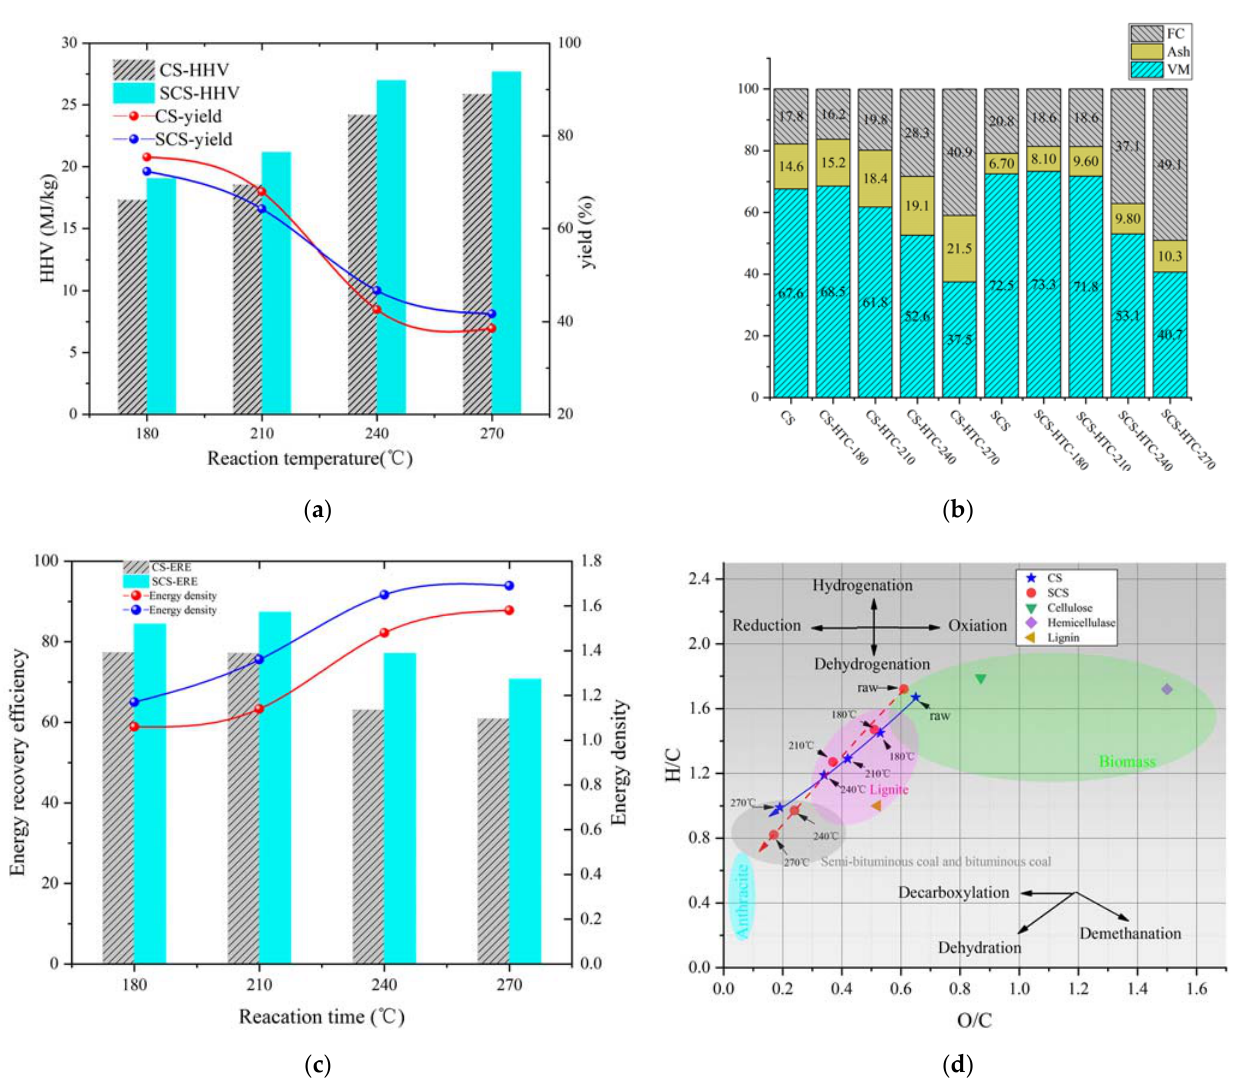
Figure 3. Fuel properties of CS, SCS, and their hydrochar. By difference: Fixed carbon% = 100% − volatile matter% − ash% ( a ) HHV and solid yield ( b ) Energy density and energy recovery efficiency ( c ) Proximate analysis ( d ) Van Krevelen.